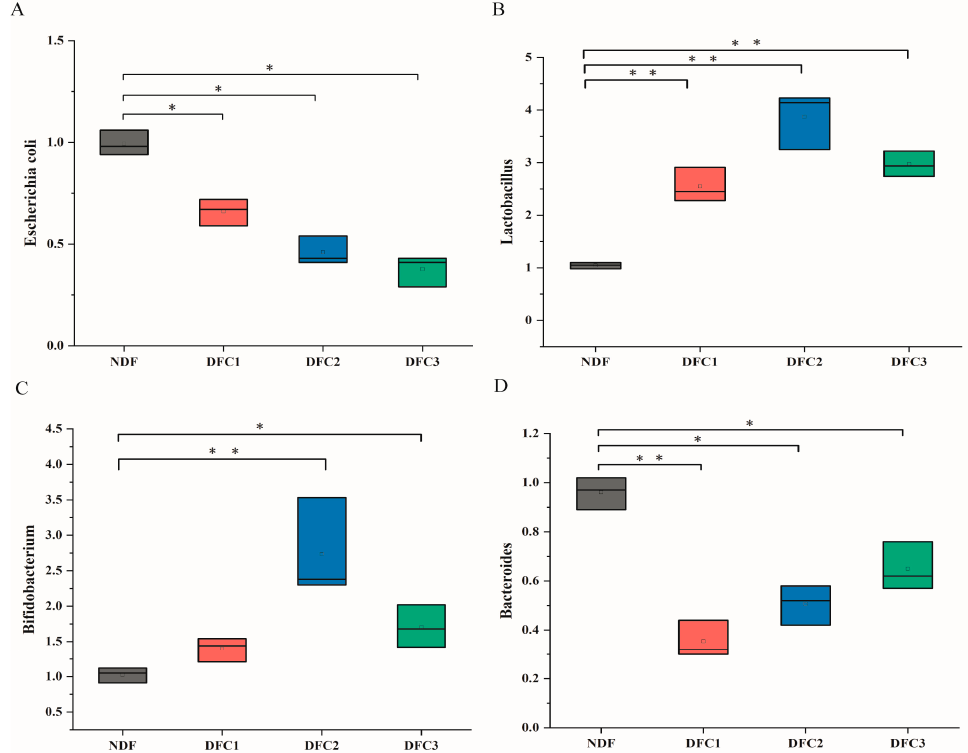
Figure 2. ( A ) Relative expression of Escherichia coli after different DFC fermentations. ( B ) Relative expression of Lactobacillus after different DFC fermentations. ( C ) Relative expression of Bifidobac- terium after different DFC fermentations. ( D ) Relative expression of Bacteroides after different DFC fermentations. * p < 0.05; **, p < 0.01, significance relative to the NDF group.